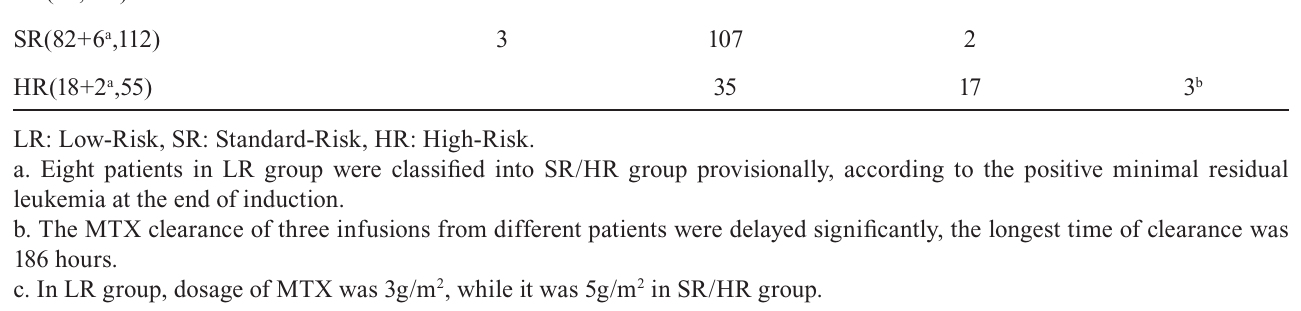
Groups (Patients, infusion c